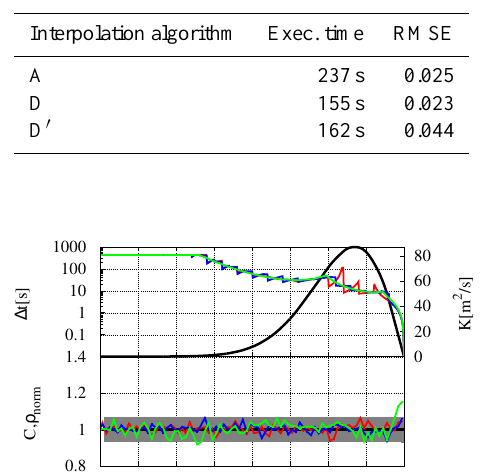
Fig. 7. Experiments with the sampled ‘average’ diffusivity distri- bution for the interpolation algorithms D (blue), D ′ (green) and A (red). Top panel: Diffusivity profile as interpolated by A (black) and ∆ t profiles for the different interpolation settings. Bottom panel: Normalized final concentration and expected distribution (black).